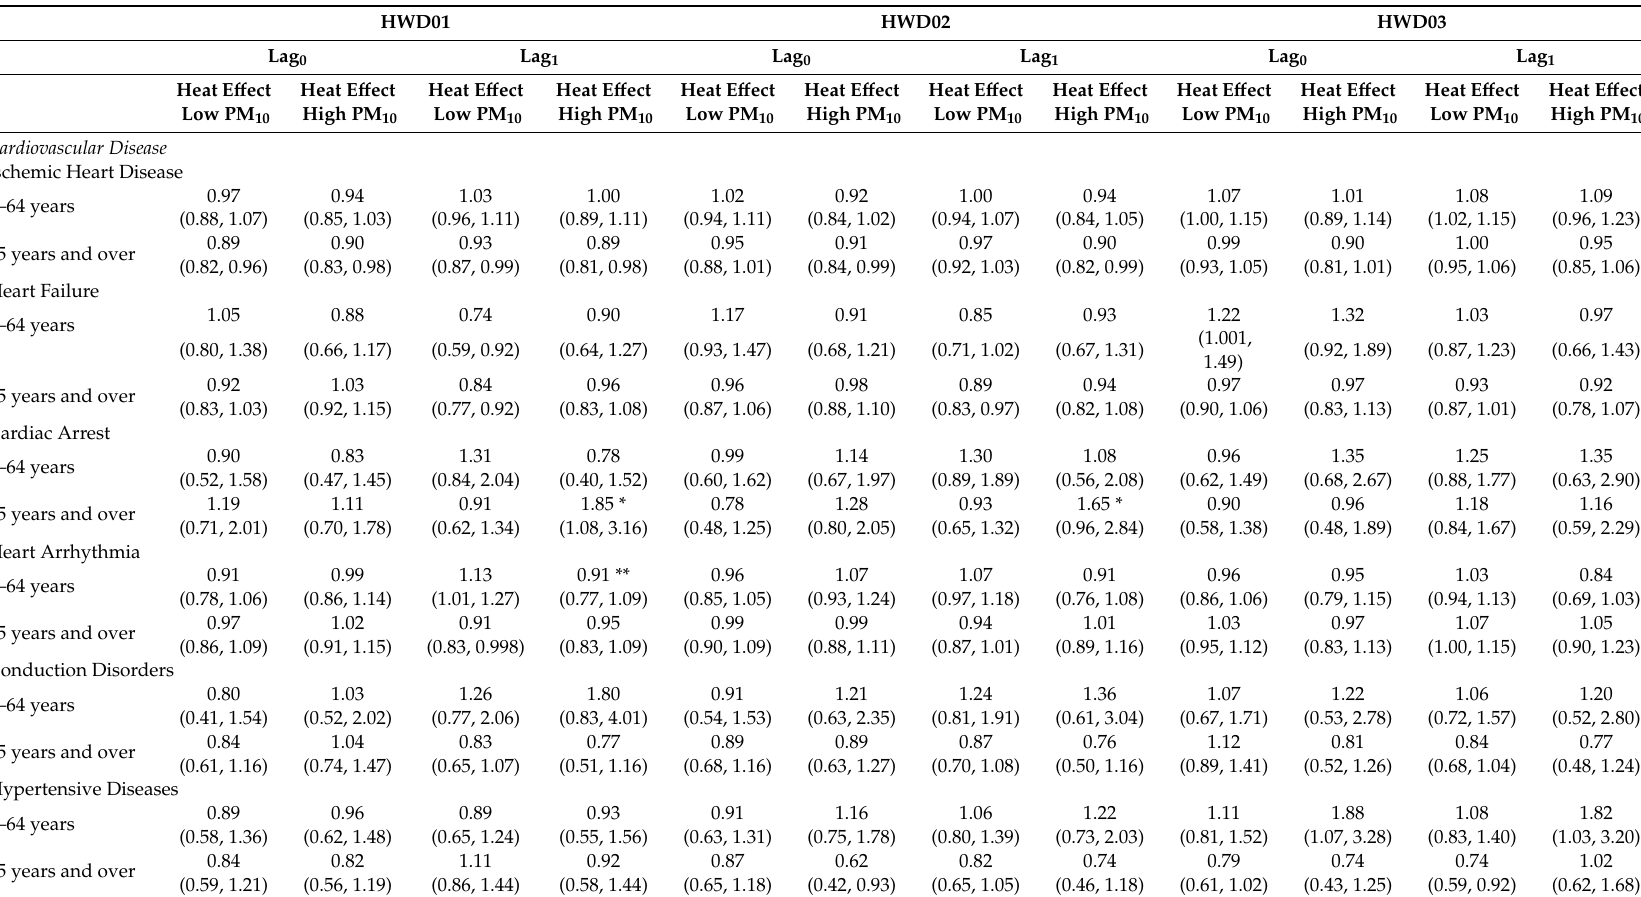
Table 5. The e ff ect of heat wave days on EHAs for six cardiovascular diseases on days with high levels of PM 10 compared to days with low levels of PM 10 in the SSD during the warm season, 2001 to 2013, for those aged 0–64 years and 65 years and over. E ff ects are presented as odds ratios with their corresponding 95% confidence